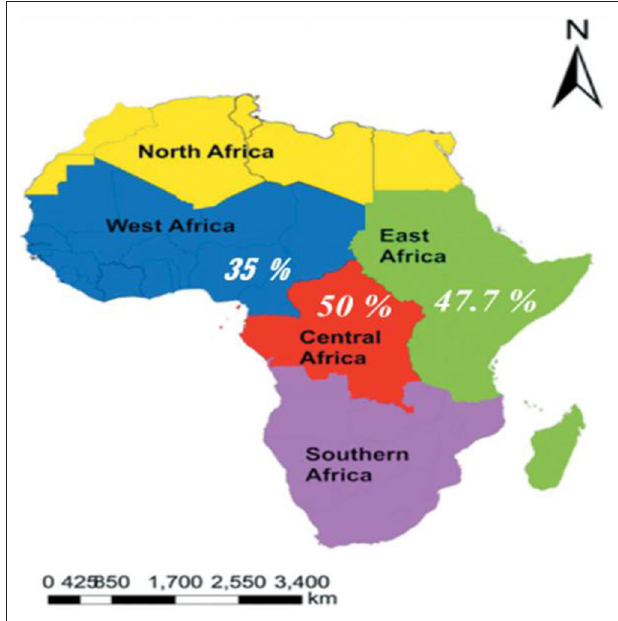
FIGURE 5 | Subgroup analyses on the pooled prevalence of episiotomy practice by African regions, 2022 (source: https://en.wikipedia.org/wiki/List_ of_regions_of_Africa).